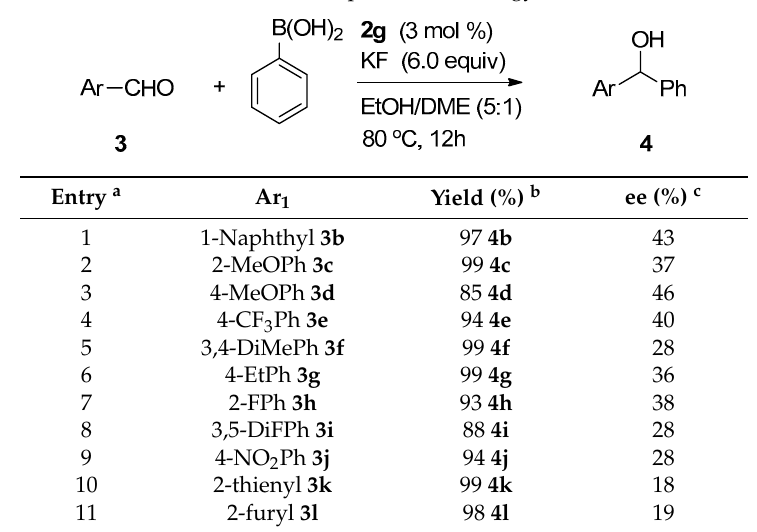
Table 3. Scope of Table 3. Scope of methodology.